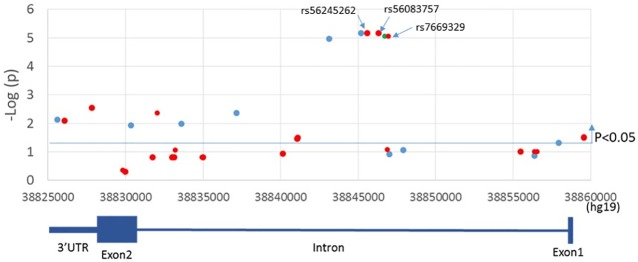
Location of SNVs associated with KD susceptibility in TLR6.Association results using the imputed GWAS database were plotted against chromosome location and gene structure of TLR6. Red dots show the SNVs for which only the affected children were homozygous recessive. SNVs above the blue line were associated with a P-value <0.05. TLR6 is encoded on the negative strand so the gene structure is shown 3’ to 5’.